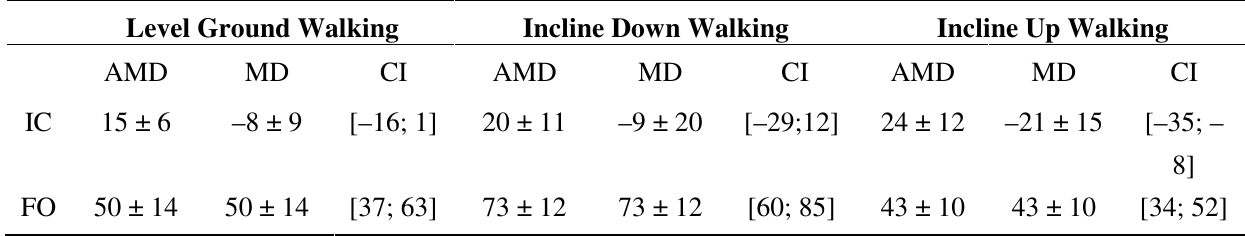
Table 3. Absolute mean difference (AMD) ± one standard deviation, Mean difference (MD) ± one standard deviation and 95% Confidence Interval (CI), all expressed in milliseconds, in the detection of Initial Contact (IC) and Foot Off (FO) between the gyroscope and the reference system. Positive MD indicates that the gyroscope method detected the event earlier than reference. n = 7 for level ground and walking up the incline, and n = 6 for walking down the